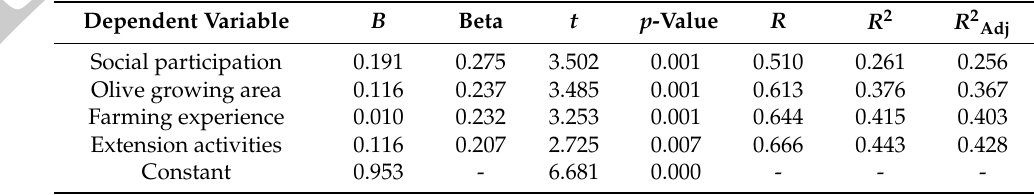
Table 5. Regression analysis on factors underpinning olive farmers’ technical knowledge of integrated pest management